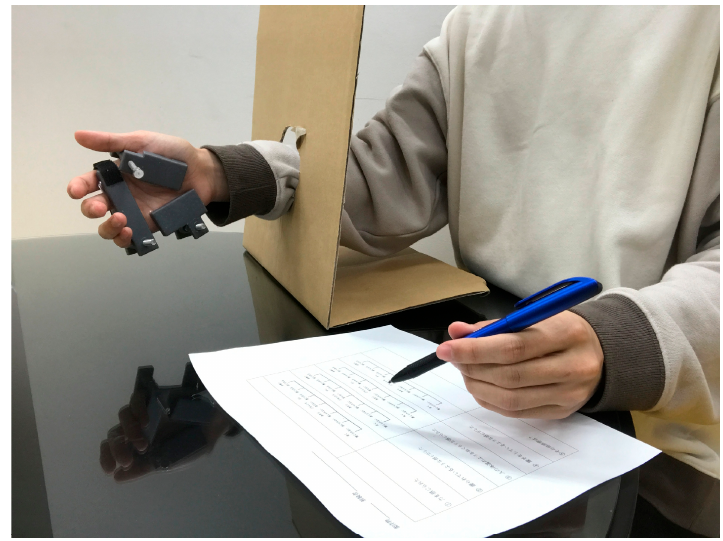
Figure 13. A photograph of the experiment. Table 3. Questions for the sensory evaluation.